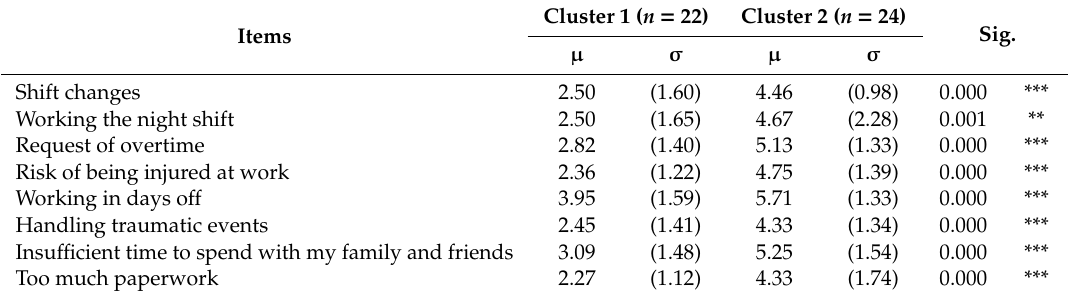
Table 2. Descriptive analysis and significance tests -ANOVA- of the attributes that form operational stressors for the two found